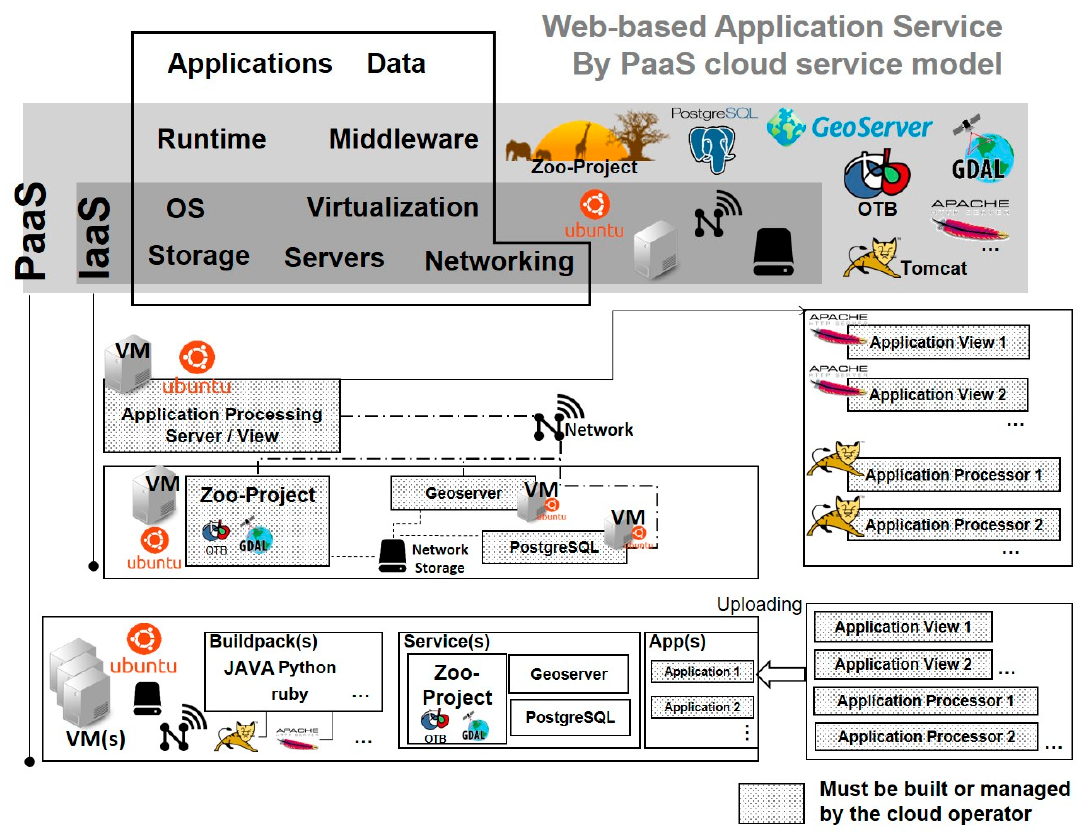
Figure 1. Basic architecture for cloud-based application services.